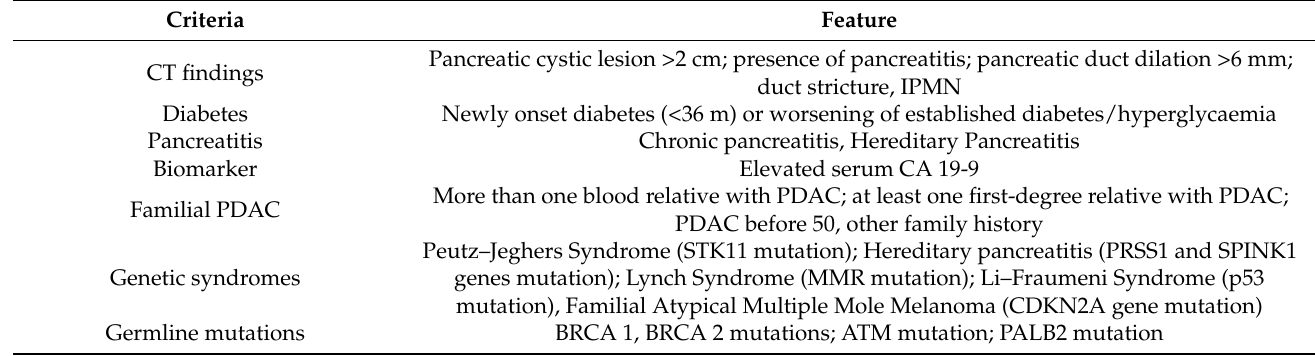
Table 1. High risk criteria for